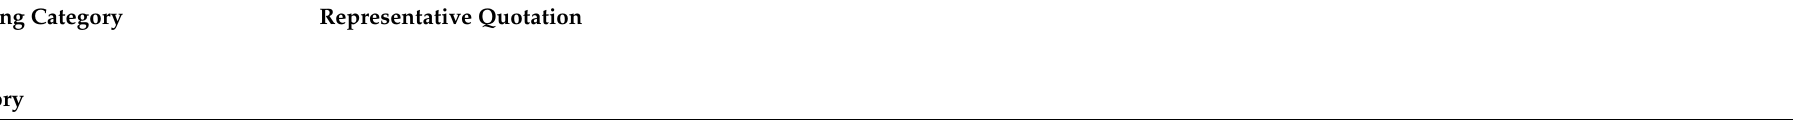
Table 4. Categories and subcategories with Representative Quotations of